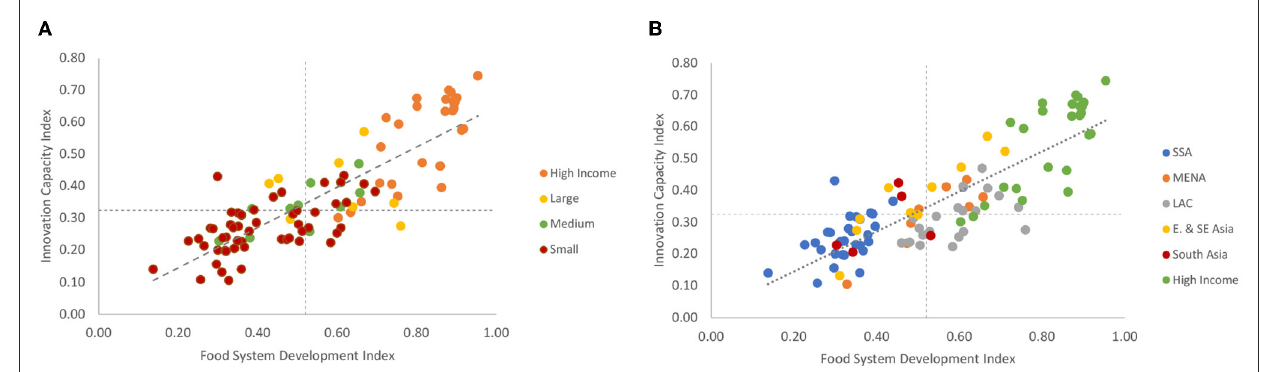
FIGURE6 Food system development vs. innovation capacity. (A) By size of the research system. (B) By geographic region. Sources: Elaborated by authors based on Schwab (2018), Schwab (2019), Agricultural Science and Technology Indicators (2022), FAO (2022), SCImago (2022), United States Department of Agriculture, Economic Research Service (2022), and World Bank